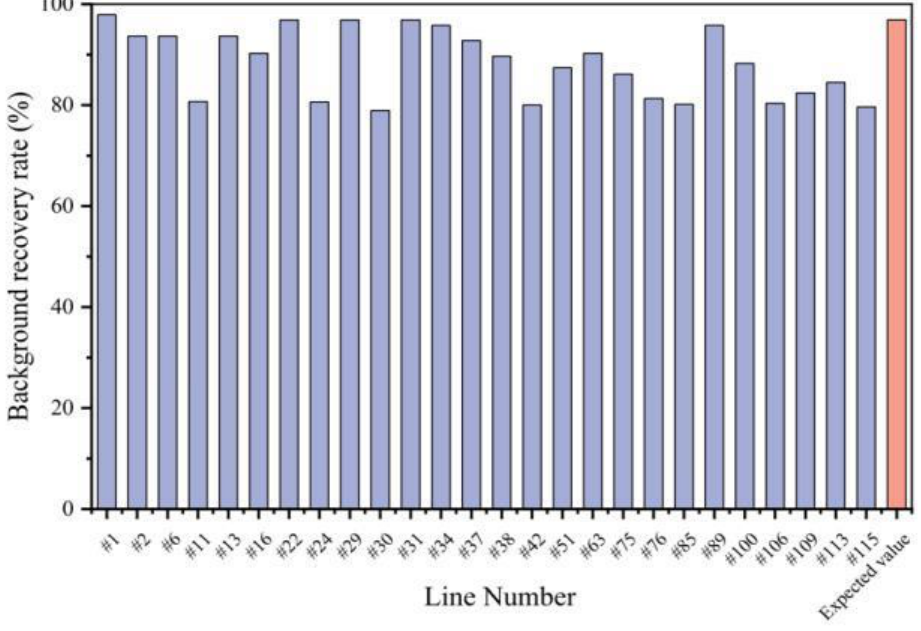
Figure 5. Background recovery rate of 26 BC 4 F 1 individual plants (#1~#115).